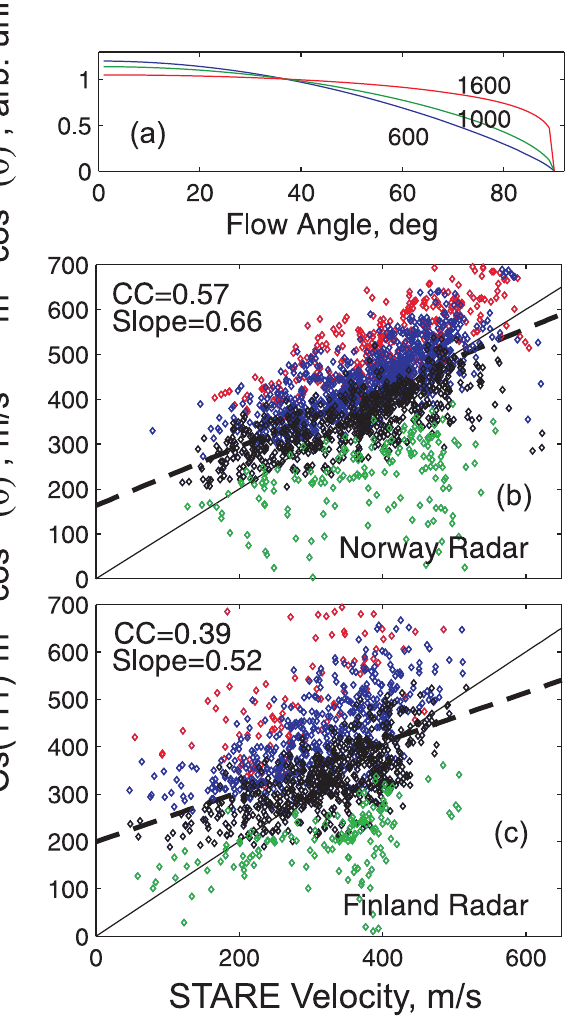
Fig. 6. The same as in Fig. 4 but for predictions based on the em- pirical equation of Nielsen et al.